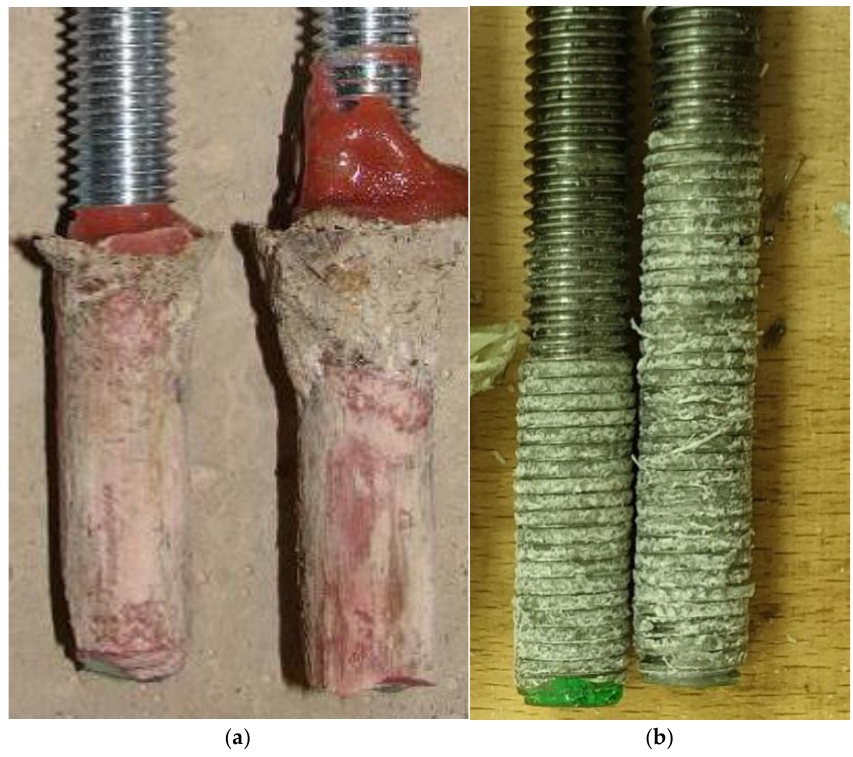
Figure 22. Failure position — (a) HILTI RE500 in concrete C20/25 ; (b) 531-AN2609 in concrete C65/70.